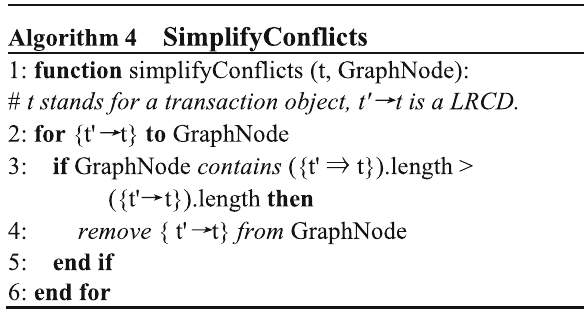
Table 5 Algorithm implementation of